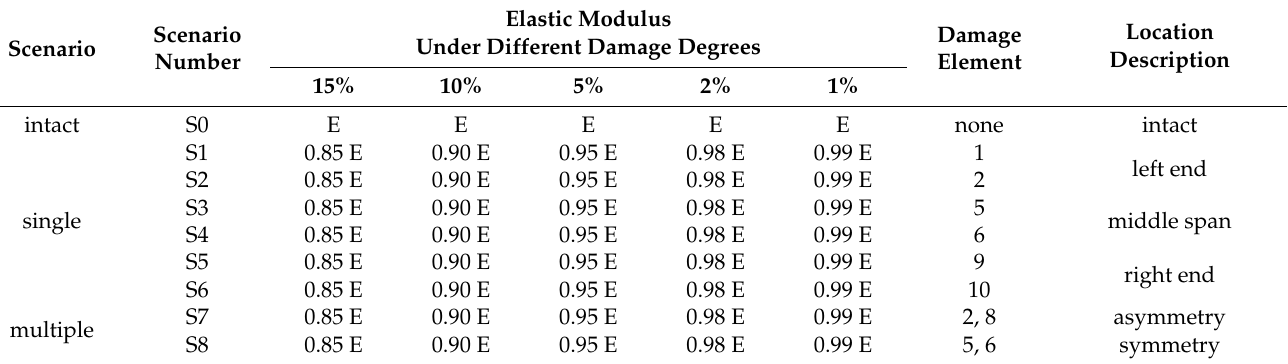
Table 4. Damage scenarios of simple supported steel beam.